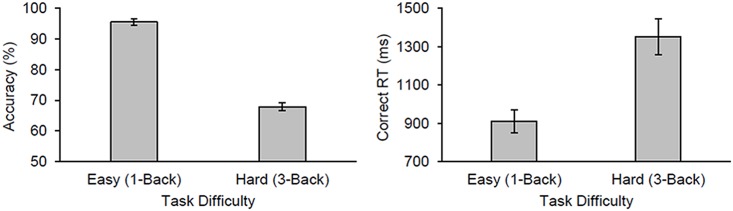
Behavioural results from Experiment 1.The mean accuracy (percentage correct) and correct response times (RTs) as a function of difficulty level in Experiment 1. The error bars reflect the standard error of the mean in this and subsequent figures.